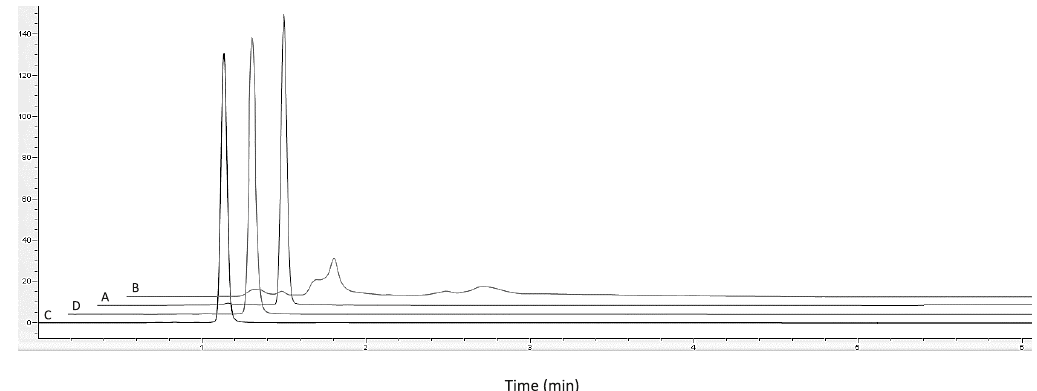
Figure2: HPLC-chromatogramsof(A,B)ASdosageformsimmediatelyaftercompoundingandafter45daysofstorageat25 ° C/60%RH(C,D) ATH loaded formulations immediately after compounding and after 25 days of storage at 40 ° C / 75%